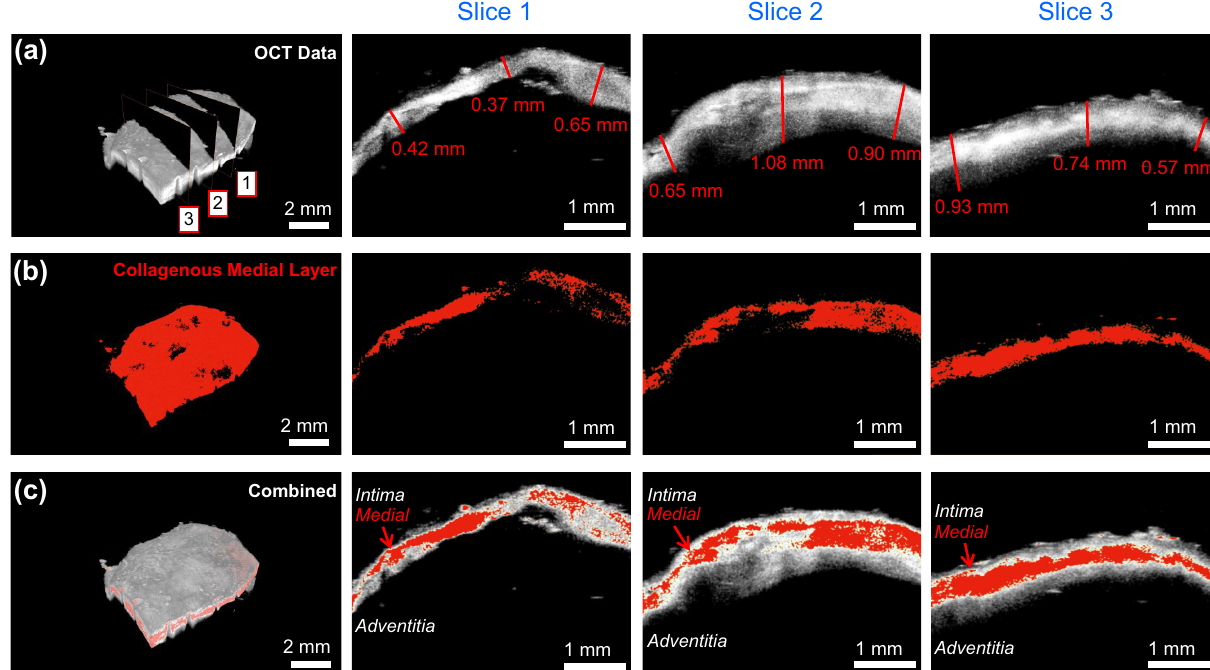
Figure 6. ( a ) Optical coherence tomography (OCT) results for the aneurysm tissue that was analyzed to quantify the ( b ) collagenous medial layer. ( c ) OCT results with the collagenous medial layer highlighted in